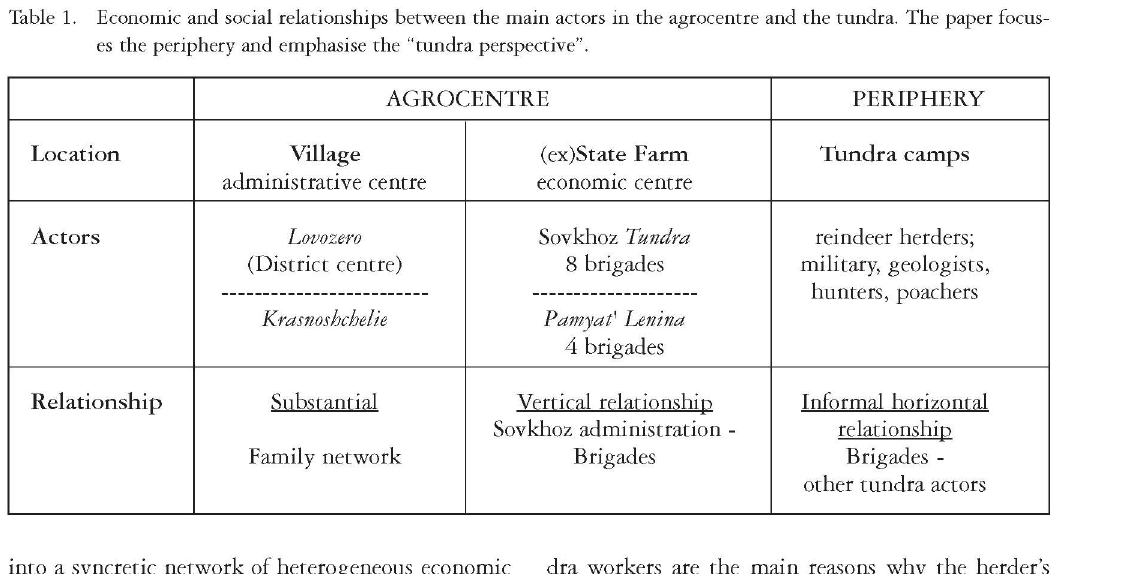
Table 1. Economic and social relationships between the main actors in the agrocentre and the tundra. The paper focus es the periphery and emphasise the "tundra